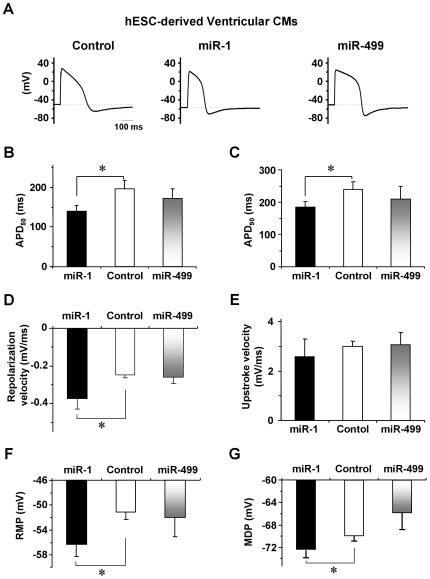
AP Parameters of Control and miR-1 and -499 Transduced hE-VCMs.A) Representative AP tracings of Control, LV-miR-1- and -miR-499-transduced hESC-derived ventricular derivatives as labeled. B-G) Bar graphs summarizing the AP parameters APD50, APD90, repolarization velocity, upstroke velocity, resting membrane potential (RMP), and maximum diastolic potential (MDP) of the groups in A).